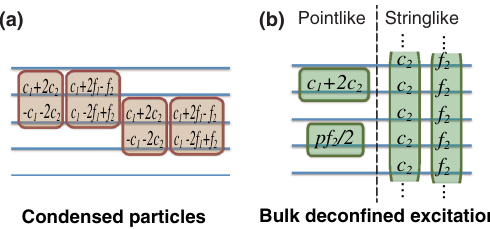
FIG. 8. (a) The condensed particles for a more generic layer- constructed 3D state. Each layer contains two identical copies of Z toric code, with p a multiple of 4. c 1 p and flux particles in the two Z (b) The set of deconfined excitations, including two types of point particles and two types of string excitations with nontrivial mutual